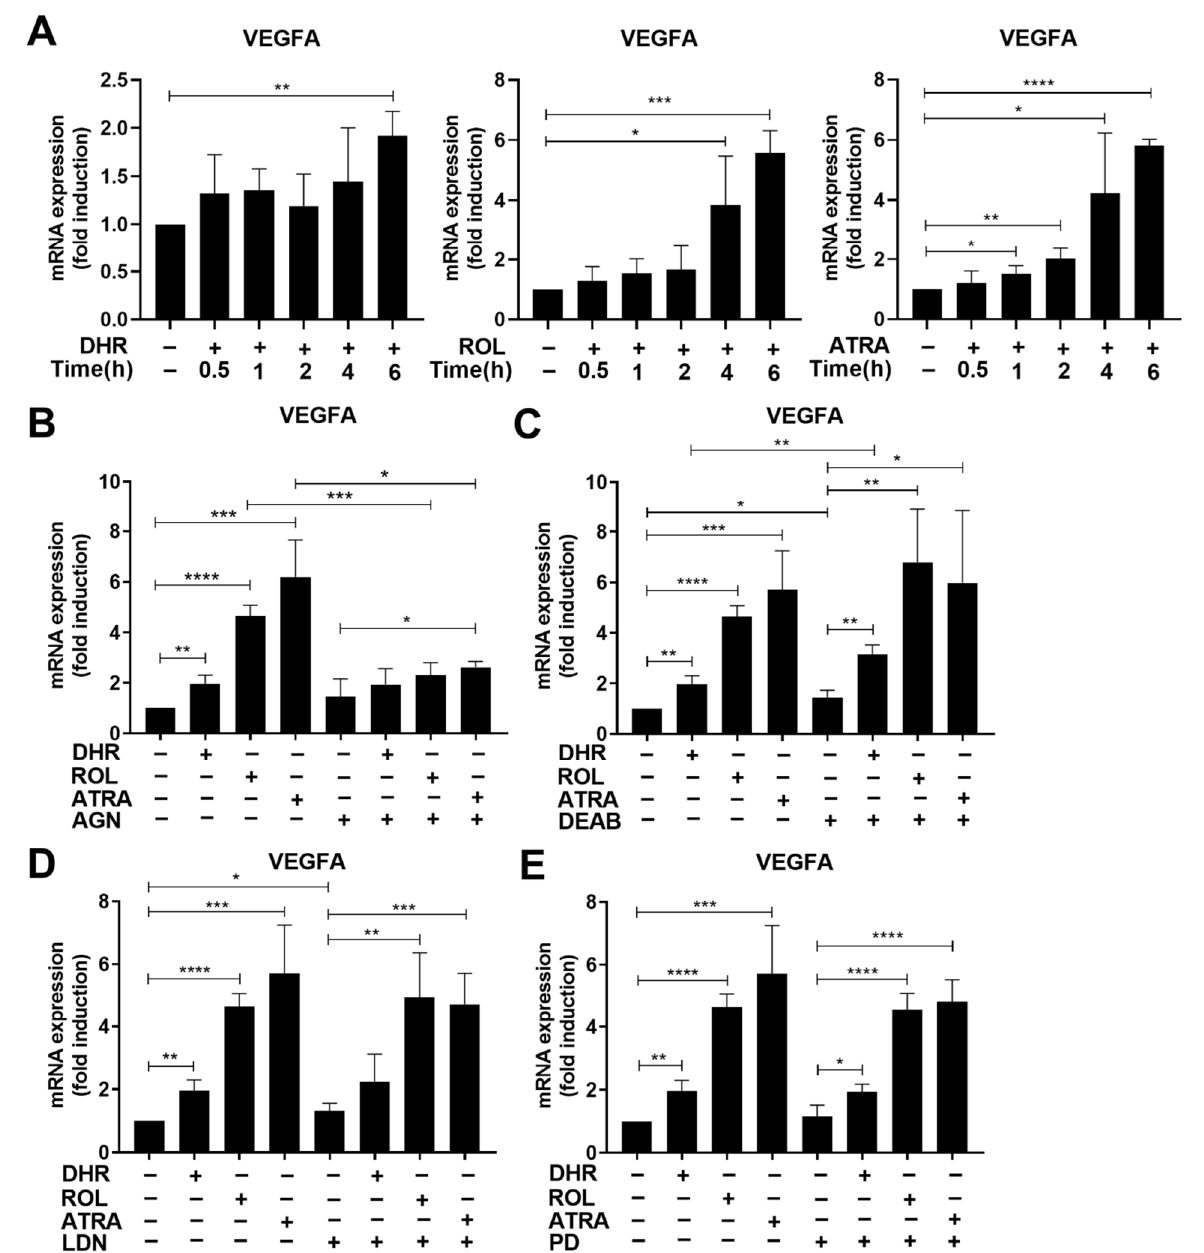
Figure 5. VEGFA is also induced by retinoids during macrophage differentiation. ( A ) Time-dependent increase in the VEGFA mRNA expression of differentiating macrophages exposed to 1 µ M DHR, 1 µ M ROL or 30 nM ATRA at day 4 of differentiation. ( B ) Inhibition of retinoid-induced VEGFA mRNA expression by AGN194310 (0.5 µ M) detected at 6 h after retinoid administration in 4-day differentiated macrophages. ( C ) Inhibition by retinaldehyde dehydrogenases by DEAB (25 µ M) has no effect on the retinoid-induced VEGFA mRNA expression detected at 6 h after retinoid administration in day 4 differentiated macrophages. Neither ( D ) LDN193189 (0.3 µ M), nor ( E ) PD98059 (5 µ M), a MEK1 inhibitor, added together with the retinoids on day 4 of macrophage differentiation, have an effect on retinoid-induced VEGFA mRNA expression detected 6 h later. All data are expressed as mean ± SD ( n = 4). β -actin was used as a reference gene for all qRT-PCR determinations. Asterisks indicate statistically significant difference (* p < 0.05, ** p < 0.01, and *** p < 0.001, and **** p < 0.0001). Each culture contained 0.5% v / v